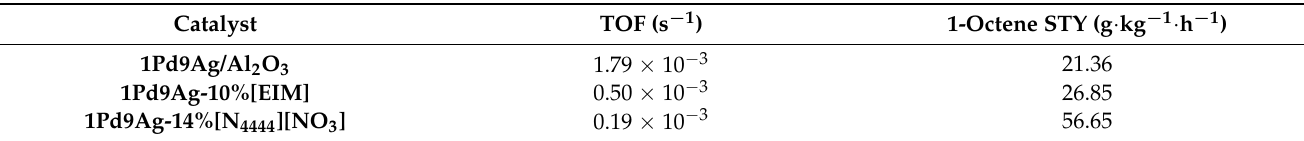
Table 2. Turn-over frequencies (TOFs) and 1-octene space – time yield (STY) of the catalysts at 1 ML coverage.